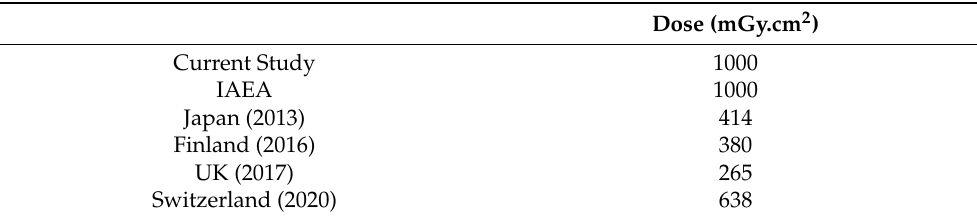
Table 2. Current study’s proposed dose compared to those of previous